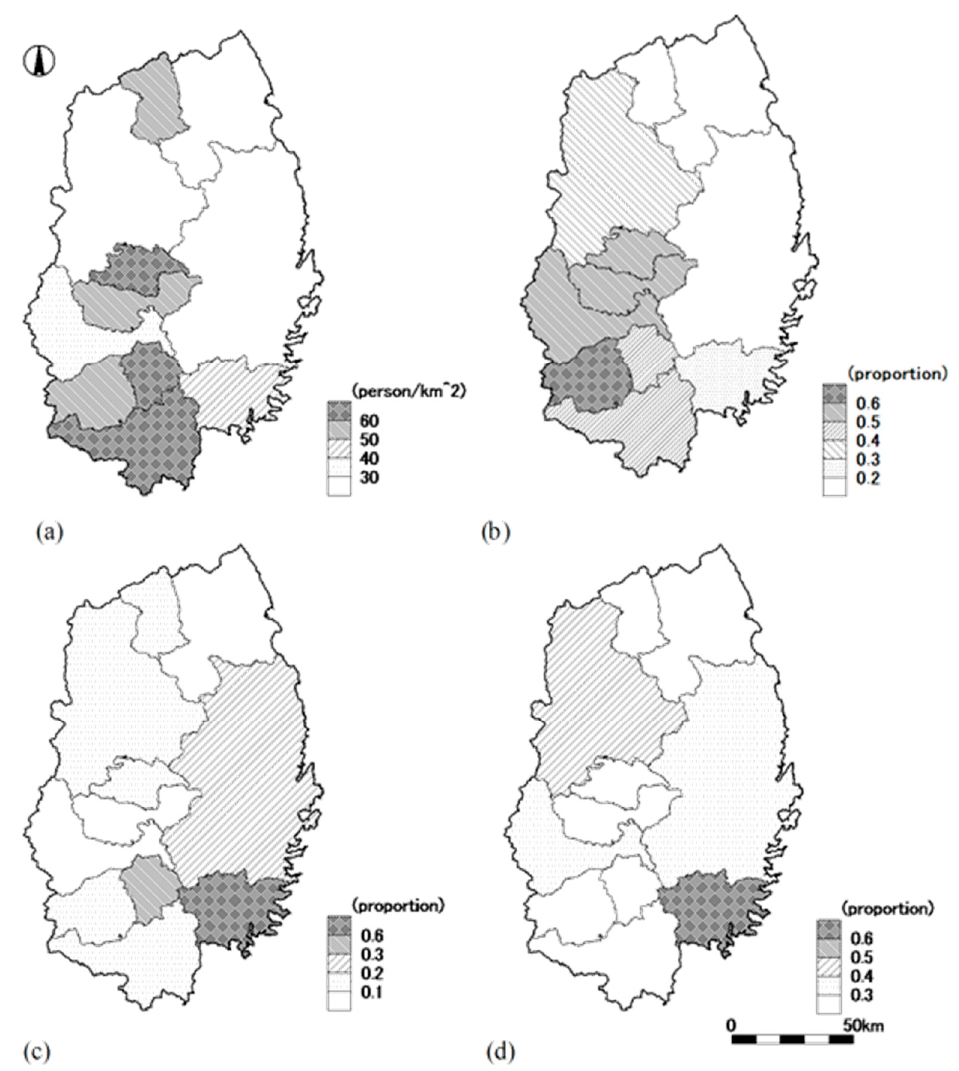
Figure 5. Specifications map for each county in Iwate Prefecture. ( a ) Population density, ( b ) proportion of paddy fields to total farmland, ( c ) proportion of villages producing firewood to total villages, and ( d ) proportion of villages producing chestnuts ( Castanea crenata ).